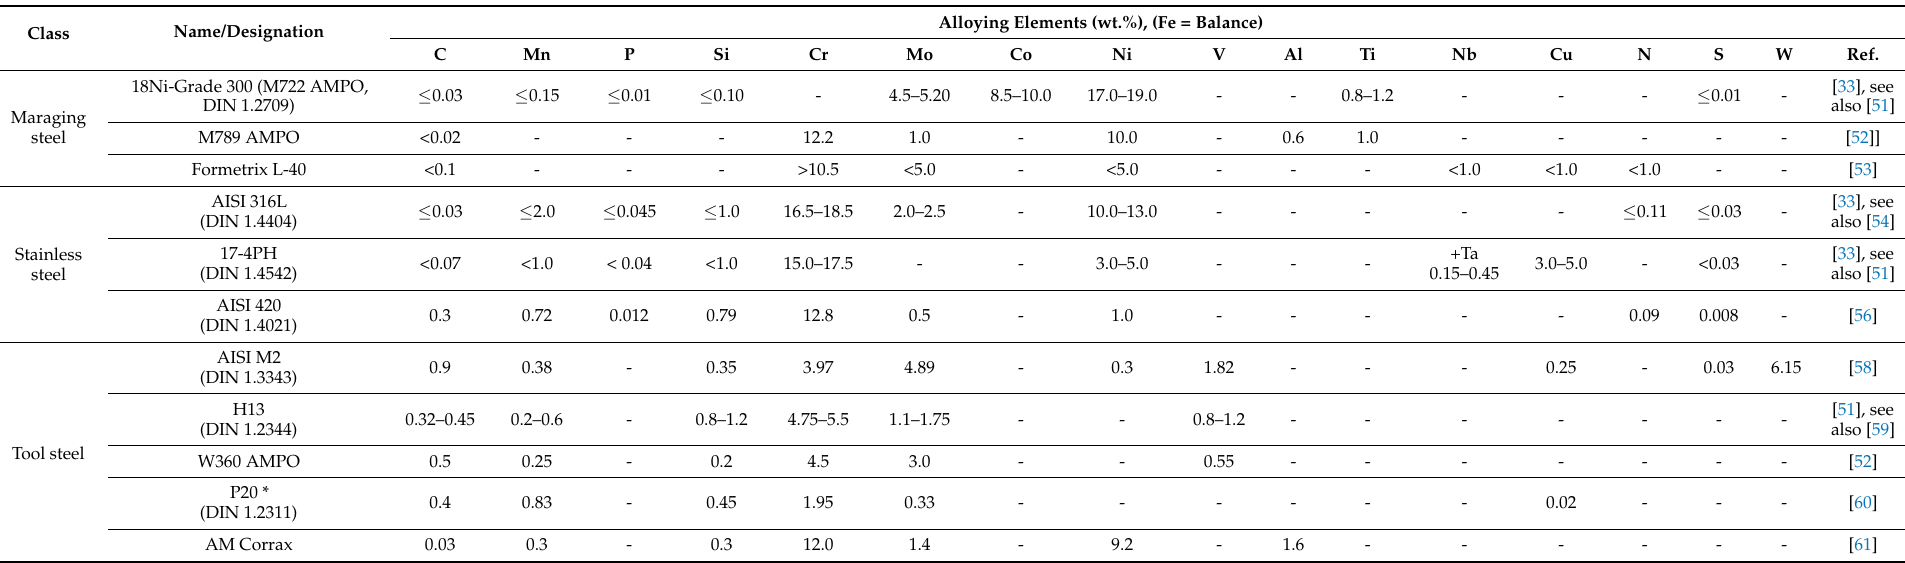
Table 6. The chemical composition of the major tool powder steels for additive